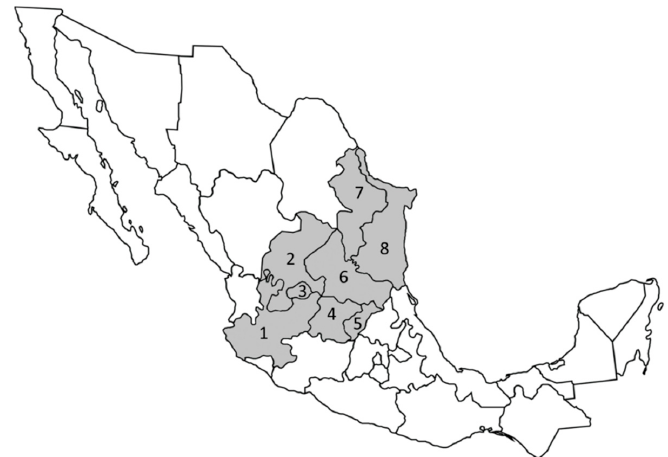
Figure 3. Galphimia glauca distribution in Mexico according to Anderson [2]. Gray color indicates the corresponding states. 1. Jalisco; 2. Zacatecas; 3. Aguascalientes; 4. Guanajuato; 5. Queretaro; 6. San Luis Potosi; 7. Nuevo Leon; 8.